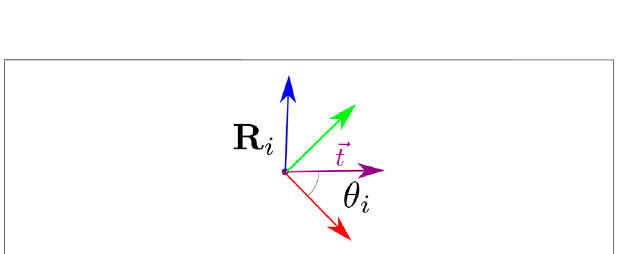
FIGURE 4 | Alignment of u x